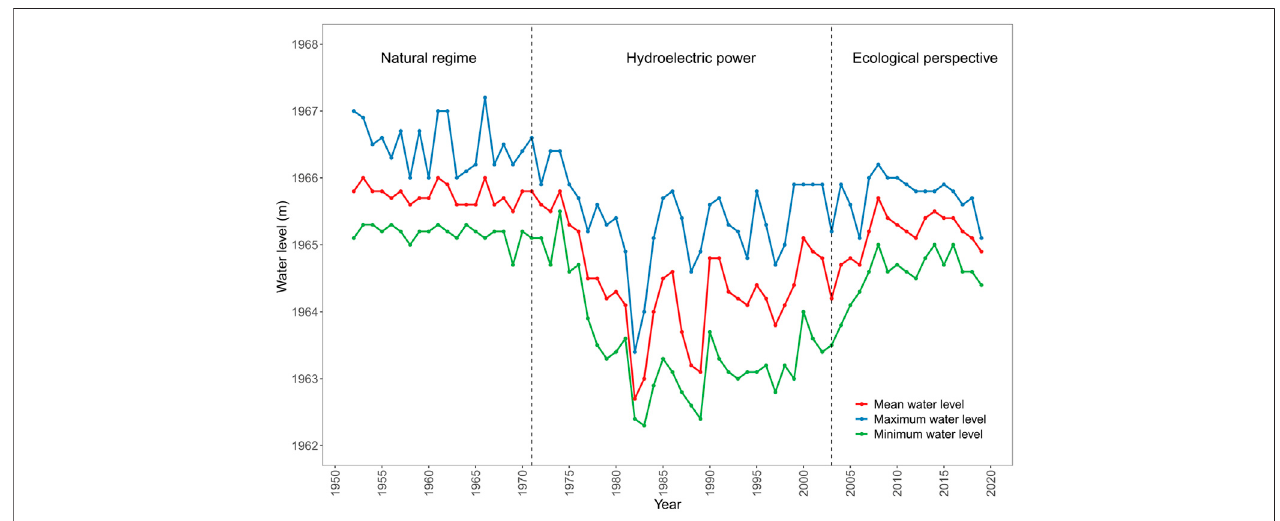
FIGURE 2 | Mean, maximum, and minimum annual water levels in Erhai Lake from 1952 to